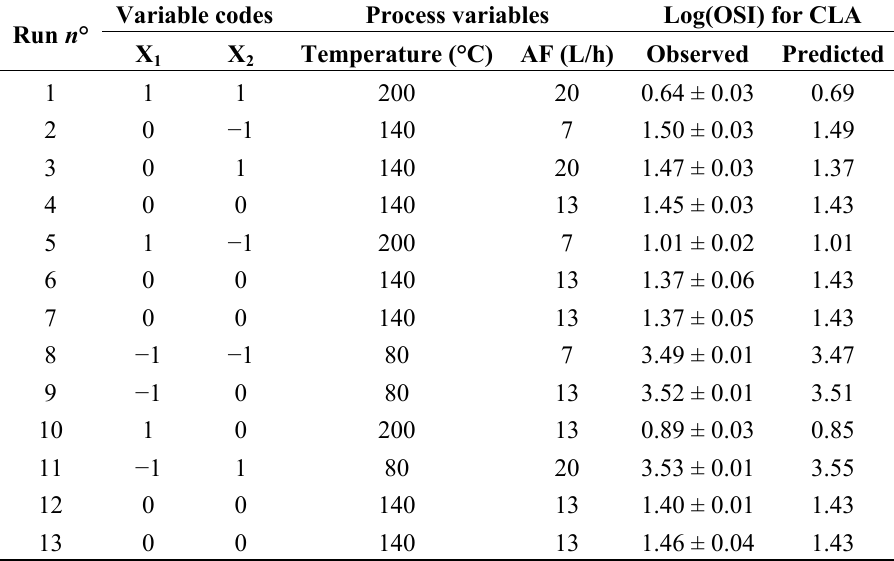
Table 1. Three level factorial design for the induction period of the conjugated linoleic acid (CLA) oil’s stability index, with corresponding observed and predicted